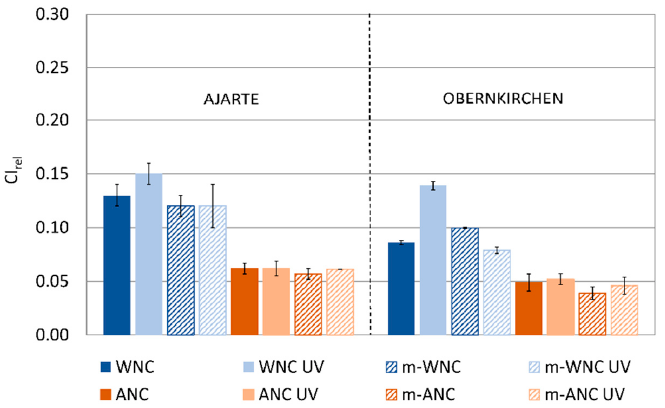
Figure 7. CI rel values of Ajarte and Obernkirchen stones treated with WNC, ANC, m-WNC and m-ANC before and after UV ageing for 600 h.